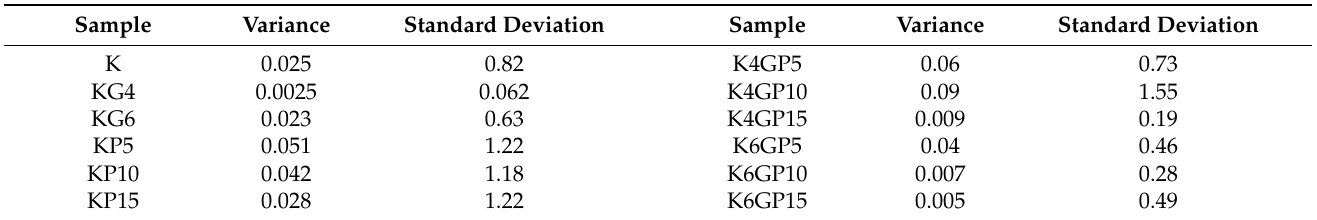
Table 5. Summary of variance and standard deviation of the specimen of shear strength after 7 curing days.